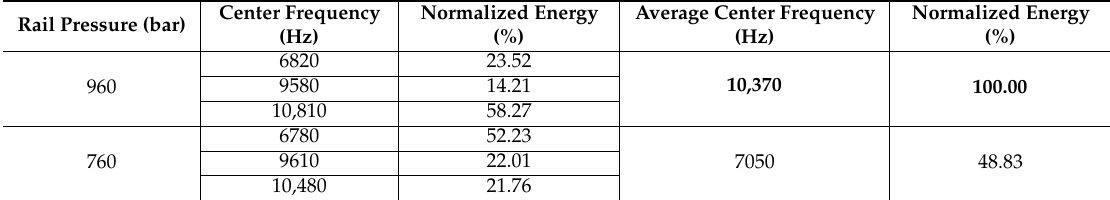
Table 7. Average Center Frequency and Normalized Energy of 960 and 760 bar.